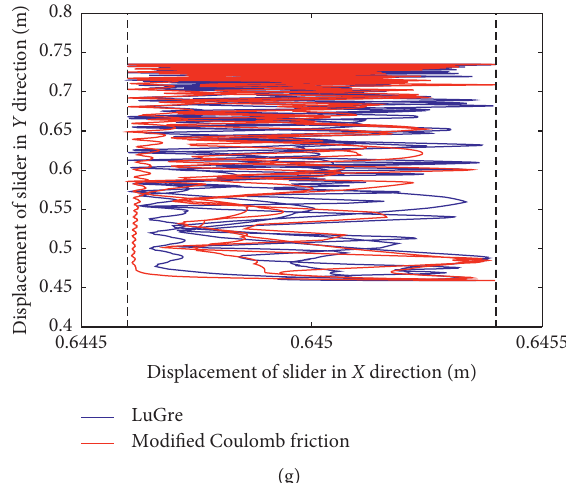
Figure 7: Dynamic response with mixed clearances for different friction models. (a) Acceleration of slider. (b) Contact force of slider. (c) Contact force at pair A . (d) Contact force at pair B . (e) Driving torque of crank 1. (f) Driving torque of crank 4. (g) Slider trajectory inside the